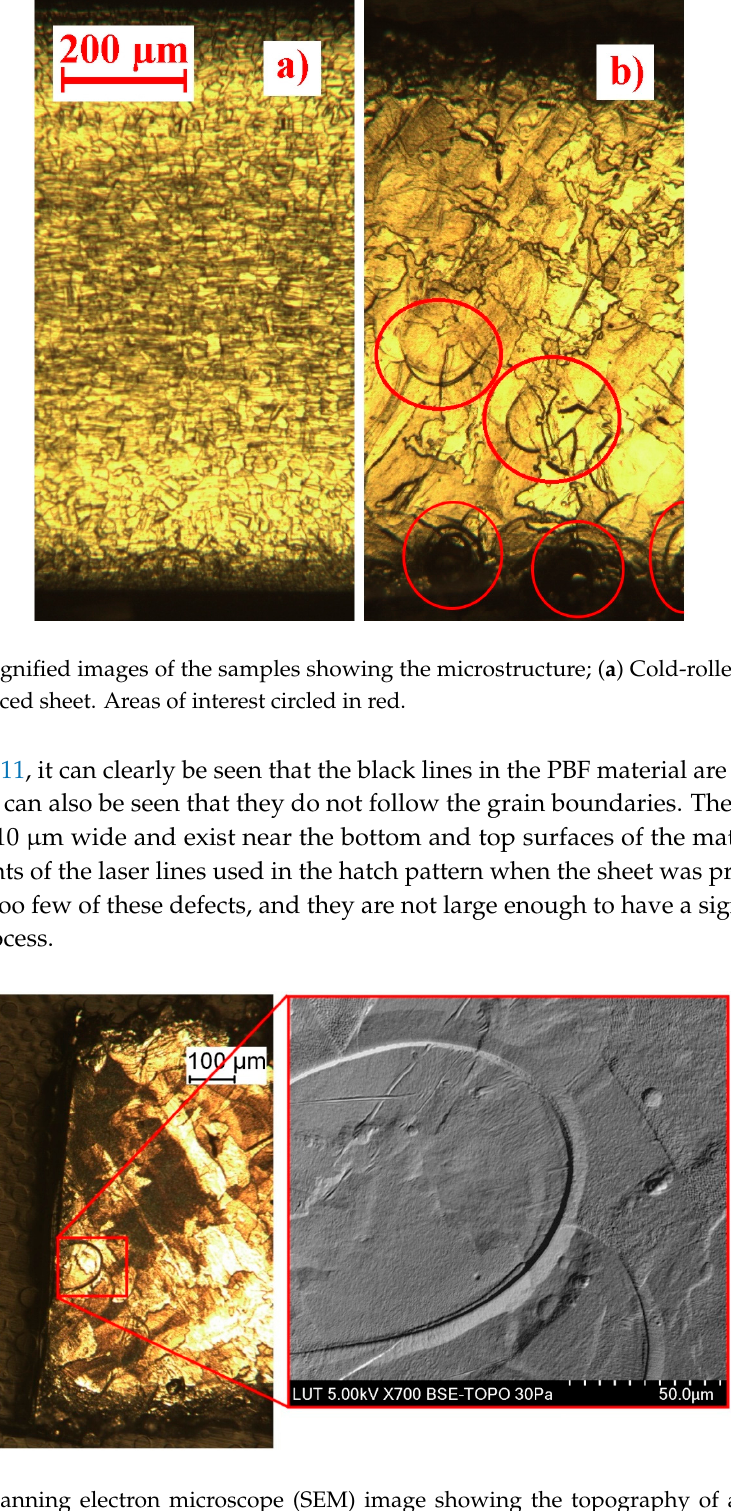
Figure 11. Scanning electron microscope (SEM) image showing the topography of an area with a suspected defect in the PBF sheet.